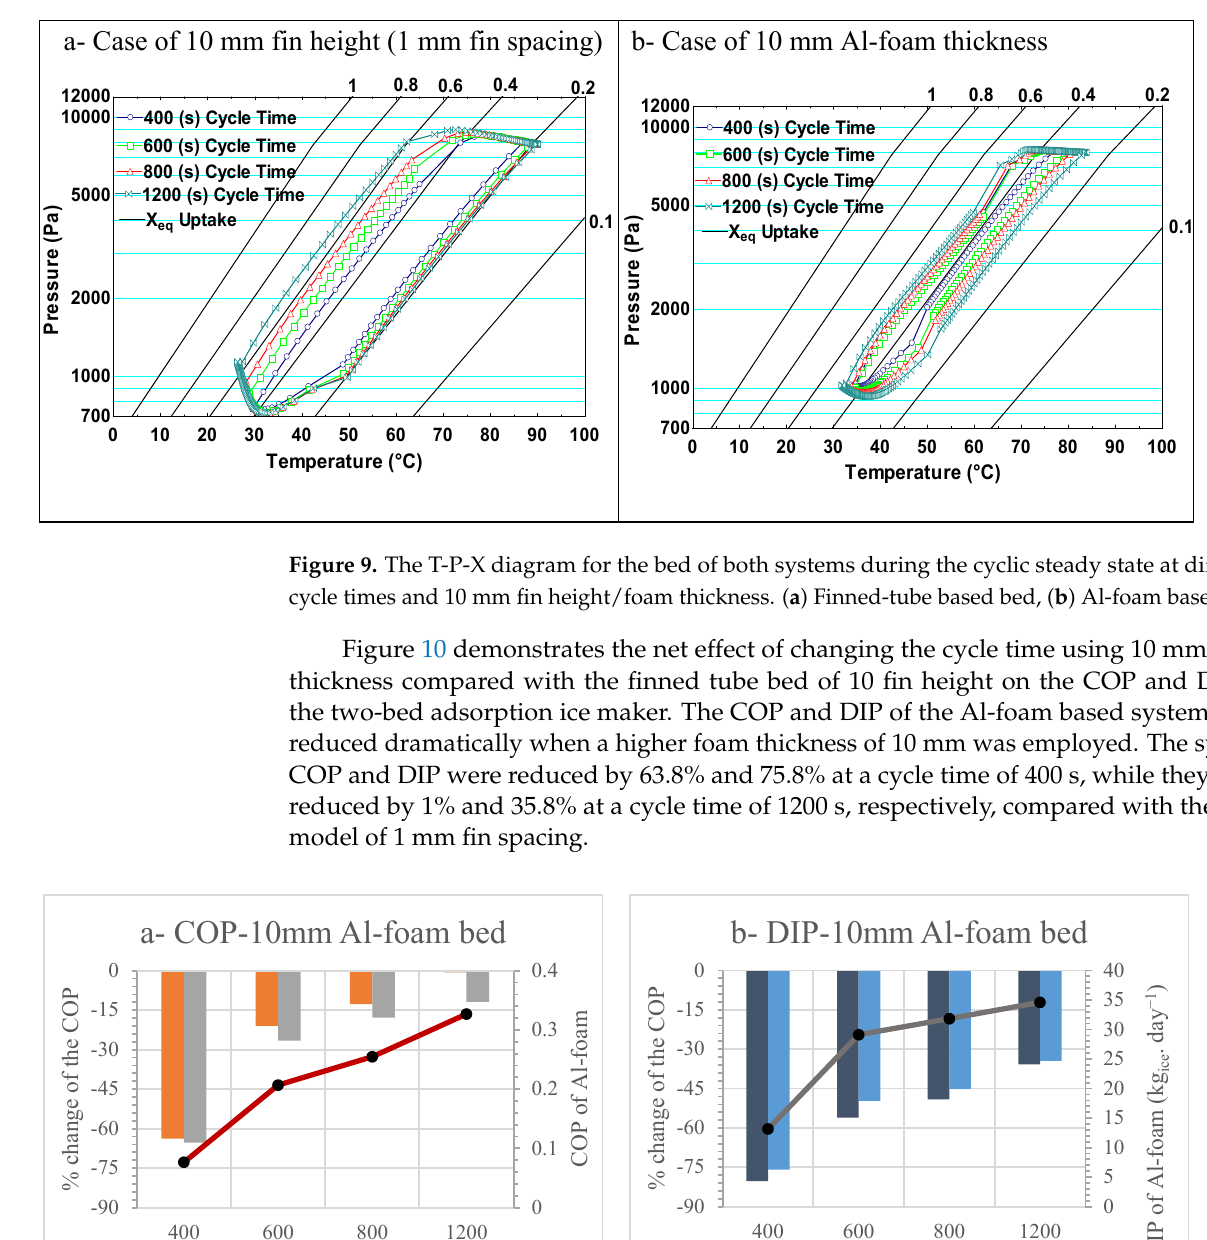
Figure 10. Effect of the cycle time on the percentage change in the system COP and DIP when using Al ‐ foam bed with 10 mm thickness. ( a ) COP, ( b ) DIP. Increasing the cycle time from 400 s to 1200 s in the case of the Al ‐ foam based system enhanced considerably both COP and DIP as they increased by 326% and 163%, respec ‐ tively. Using the higher foam thickness of 10 mm should be associated with higher cycle time, which needs more investigation in future work as a small number of tubes in the adsorbent bed could be preferred to reduce the circulated heating and cooling water flow rates in a certain application. In addition, an adsorbent bed with ethanol refrigerant in adsorption ice production systems works under very high vacuum pressures, which makes the mass transfer mechanisms in the adsorbent domain play a critical role. In such a case, increasing the permeability of the foamed adsorbent bed is a crucial requirement to enhance the performance of Al ‐ foam based adsorption ice production systems com ‐ pared to the finned ‐ tube one. 5. Conclusions The present research is considered an attempt to explore the potential of using alu ‐ minum foam in contrast to the classical packing method using finned tubes in the adsor ‐ bent bed of an adsorption ice production system. A fully coupled numerical model was developed to investigate the effect of changing the cycle time along with different foam